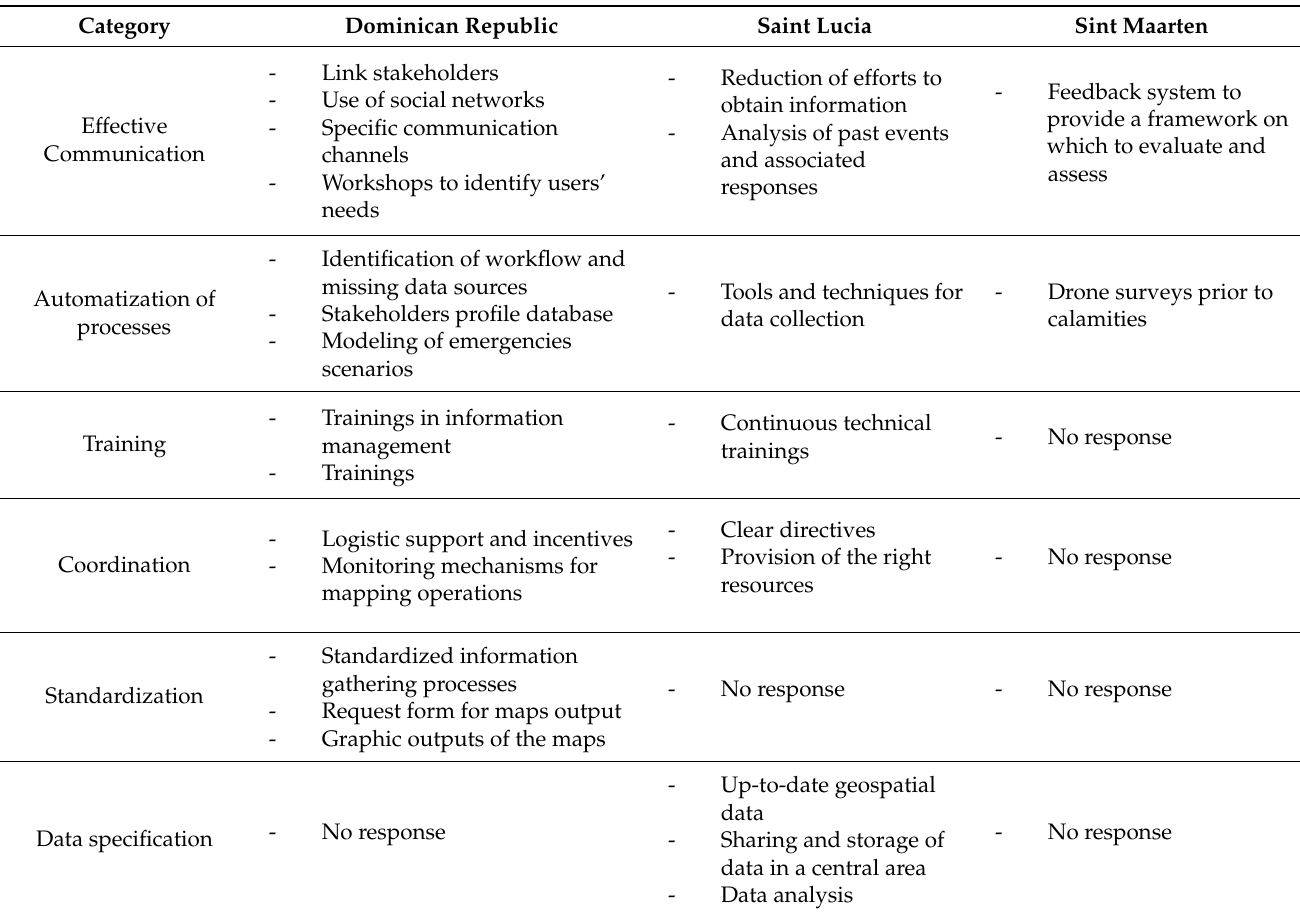
Table A1. Recommendations for anticipating EMT users’ needs (Q14).